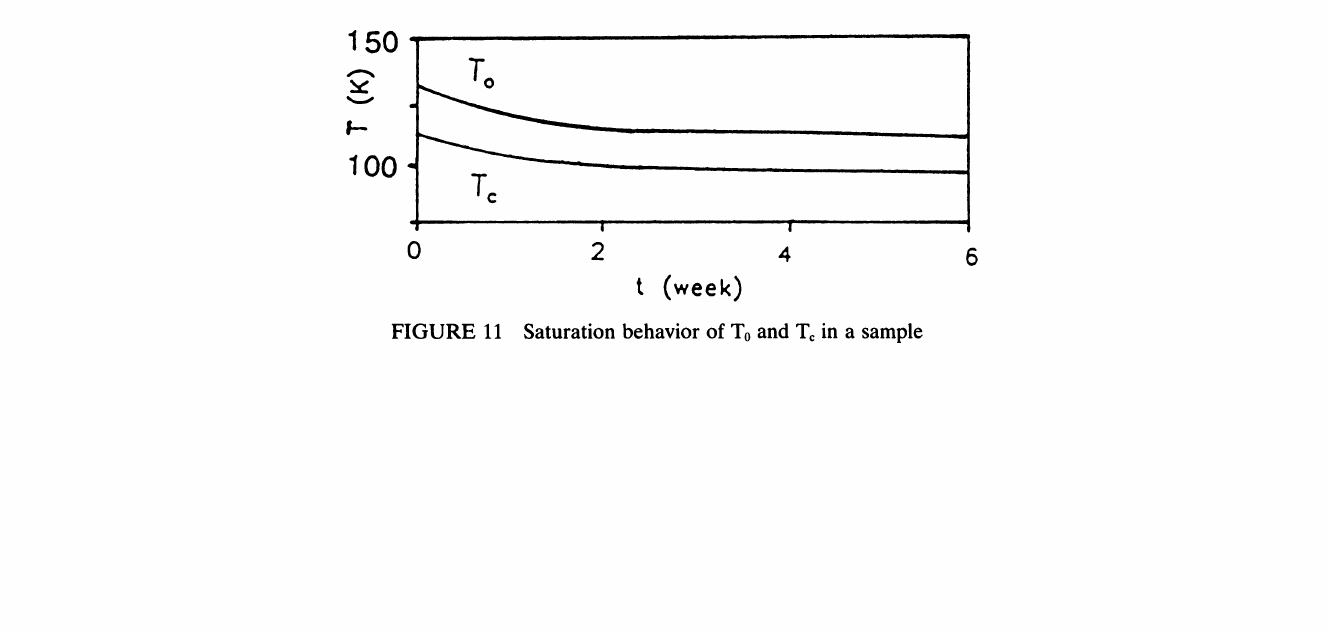
FIGURE 11 Saturation behavior of To and Tc in a